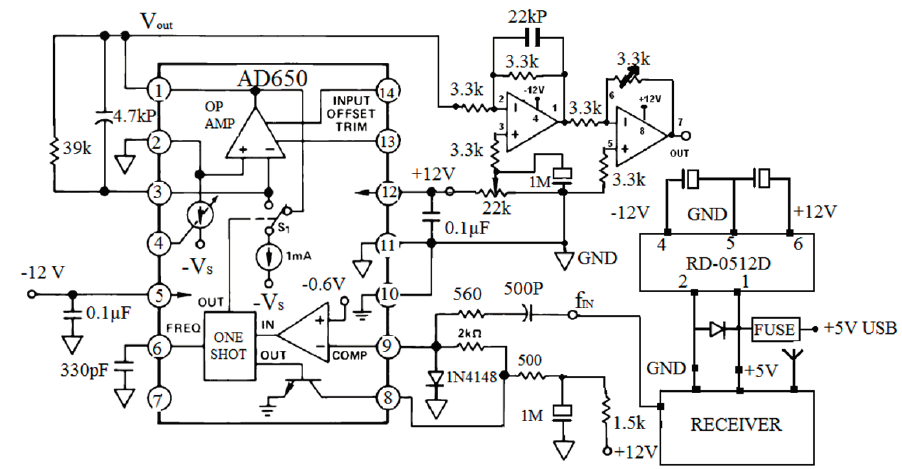
Figure 4. Circuit diagram of the receiver